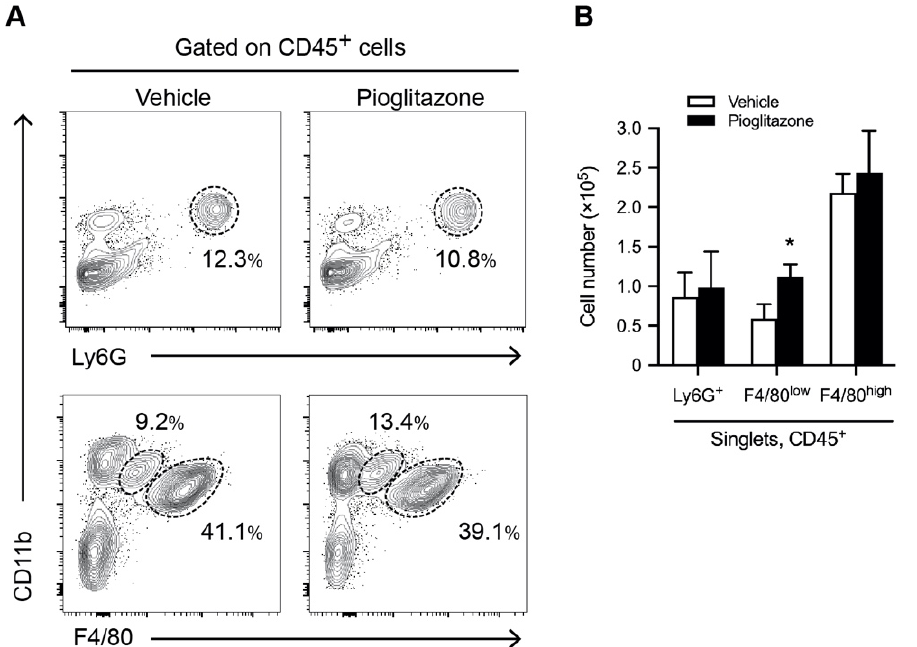
Figure 4. Pioglitazone treatment increases the number of CD11b + F4/80 low monocytes/macrophages in burned mice. Five days after burn injury, hepatic immune cells were obtained from mice 3 h after treatment with vehicle or pioglitazone. Isolated whole liver mononuclear cells (MNCs) were subjected to flow cytometry analyses. FACS plots and cell numbers of neutrophils (CD11b + Ly6G + ), recruited monocytes/macrophages (CD11b + F4/80 low ), and Kupffer cells (KCs) (CD11b + F4/80 high ) are shown in CD45 + gated whole liver MNCs isolated from burned mice with vehicle or pioglitazone treatment. Representative FACS plots ( A ) and a graphical summary ( B ) showing the cell number of indicated liver immune cell subsets. n = 6 per group. Data are represented as the mean ± SD; * p < 0.05 vs. vehicle.